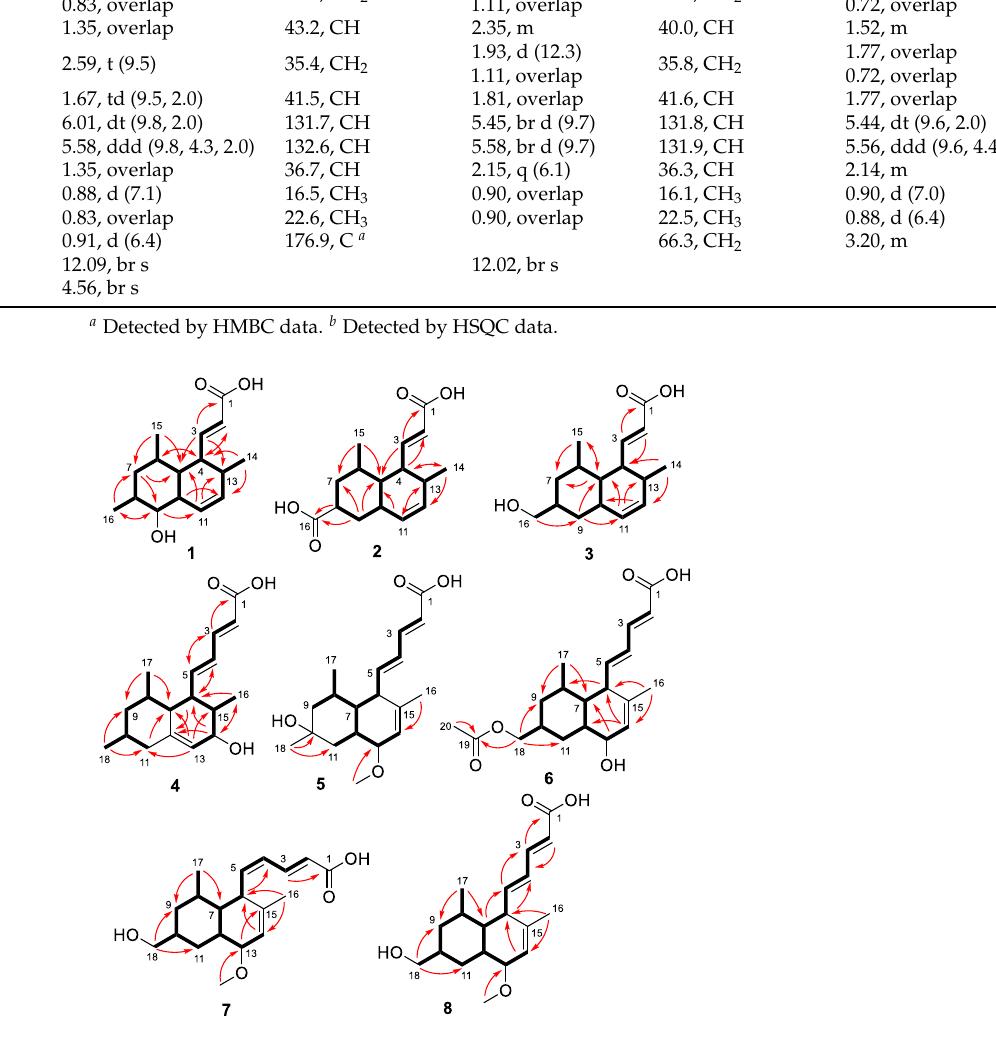
Figure 2. Key COSY (bold lines) and HMBC (arrows) correlations of compounds 1 – 8 . To unambiguously confirm the structure and configuration of compound 1 , attempts to cultivate quality crystals were performed, and suitable crystals were obtained by dissolving the samples in MeOH and refrigerating them to evaporate the solvent slowly. Single-crystal X-ray diffraction analysis using Cu K α radiation confirmed the structure of 1 , and the absolute configuration was 4 S , 5 R , 6 R , 8 S , 9 R , 10 R , and 13 S with the Flack parameter − 0.09(13) (Figure